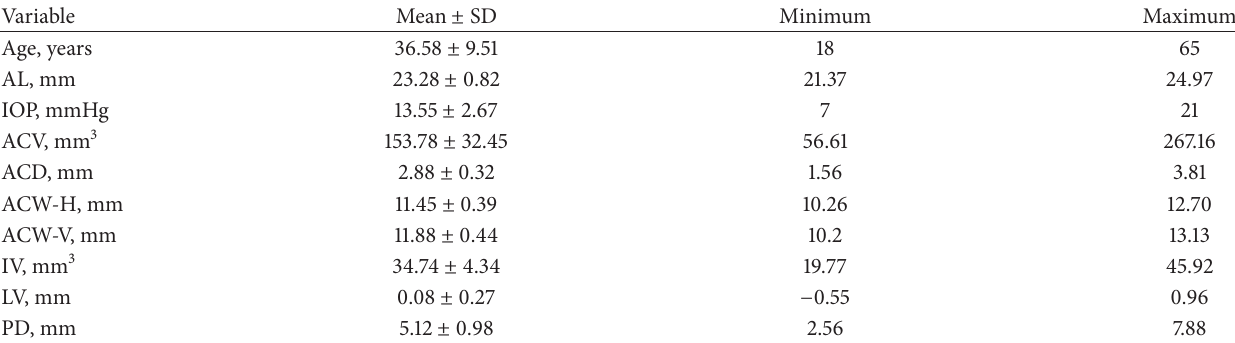
Table 1: Demographic characteristics of the subjects.